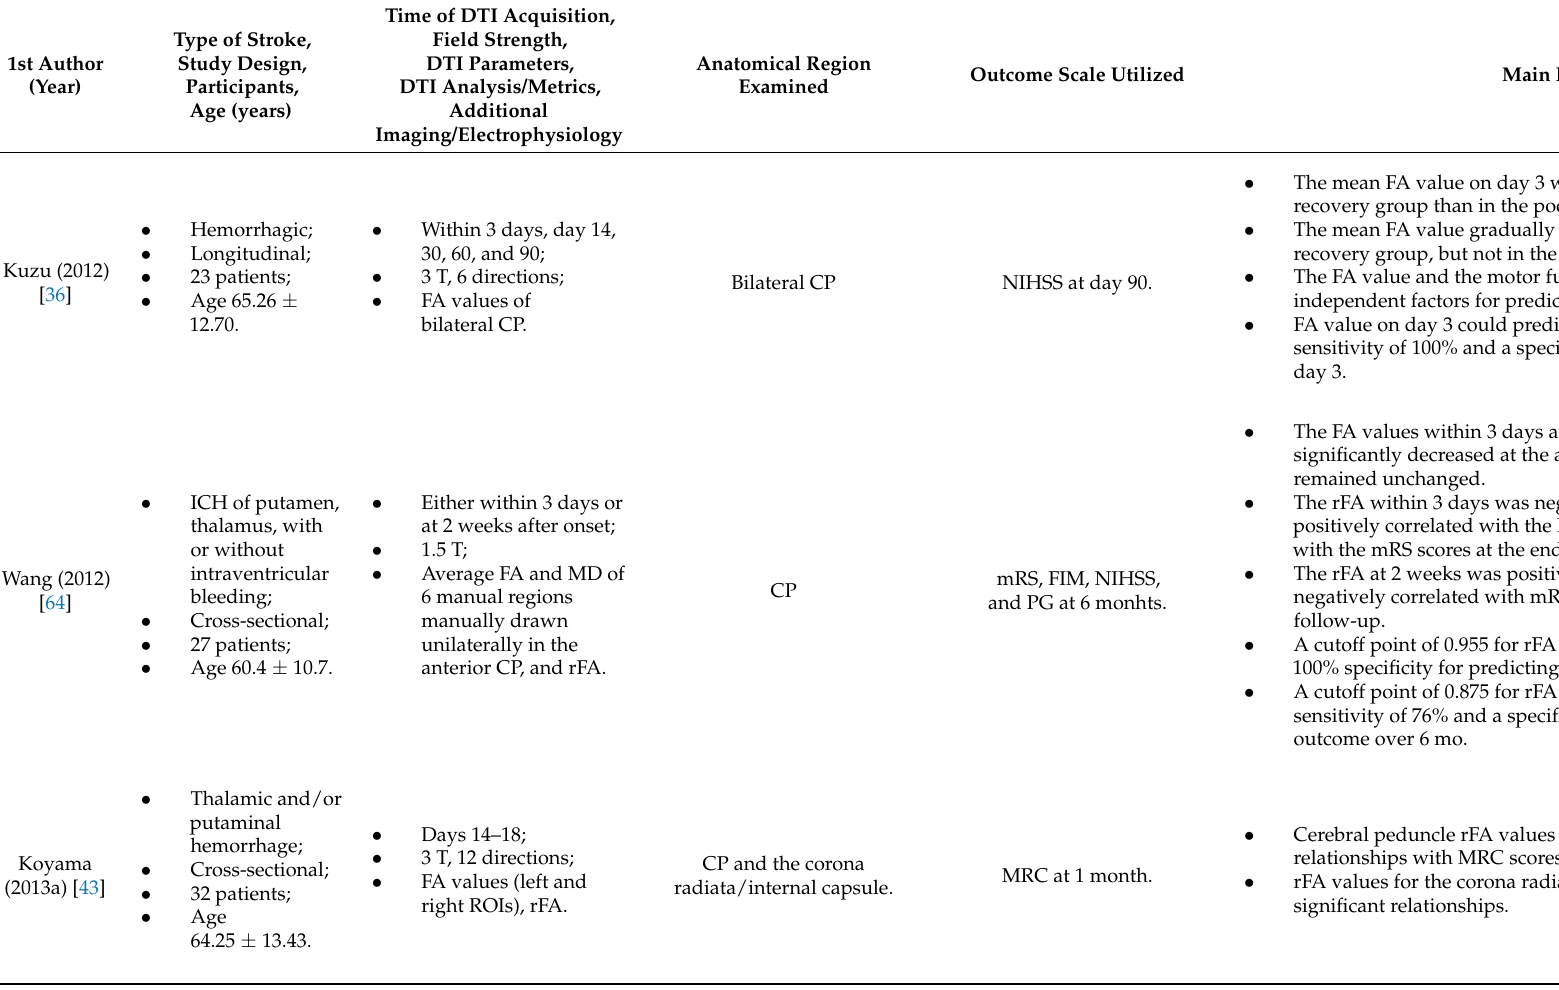
Table 2. Basic characteristics and main findings of studies including patients with hemorrhagic